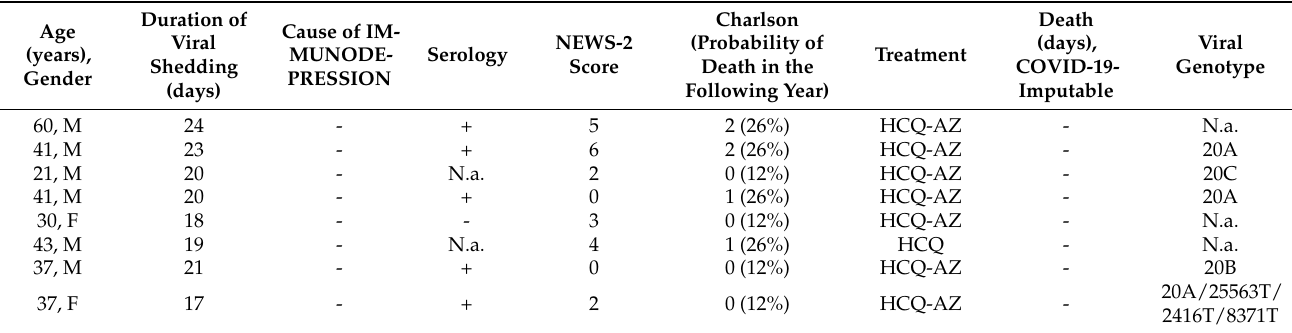
Table 1. Summary of 34 COVID-19 patients with prolonged SARS-CoV-2 viral shedding ≥ 17 days, Marseille, France,